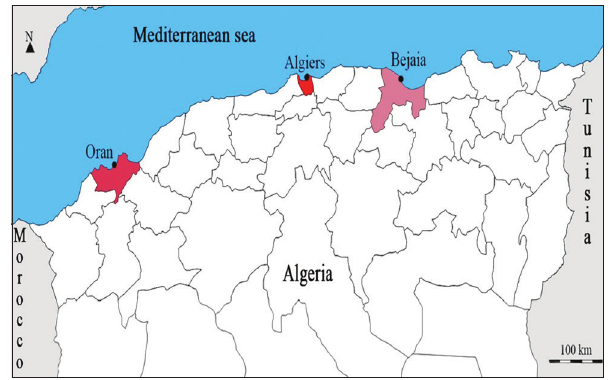
Figure-1: Geographical location of the Algerian area where the fish’s samples were